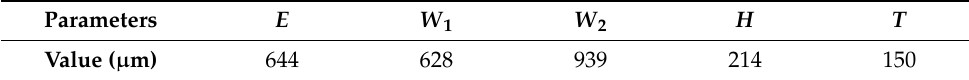
Table 8. Parameters of the leading-edge model.